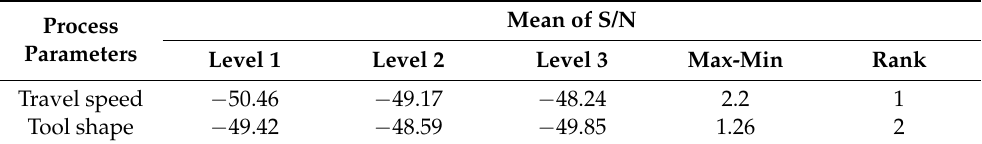
Figure 8. Contour plot for Tw against travel speed and tool shape. The results of the S/N ratio response for TSL displayed in Table 6 show that the 200 mm/min travel speed gave the highest mean S/N ratio and the Sq pin shape exhibits the highest S/N in comparison to the other pin geometries.